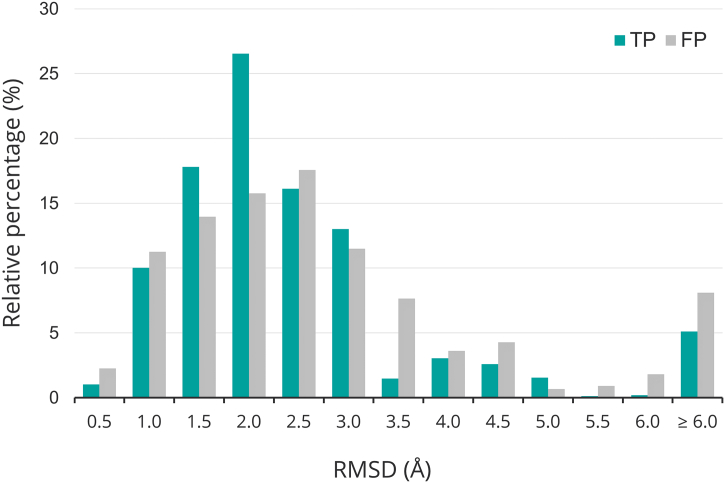
Histogram of the relative frequencies of RMSD (Å) of predicted models grouped according to whether the variant was a TP and FP. The bin labeling shows the upper bound; for example, 0.5 denotes the range 0.0 Å ≤ RMSD < 0.5 Å. The last bin is RMSD ≥ 6 Å. The relative percentage displayed on the Y axis is the fraction of true positives and similarly the fraction of false positives in each bin range.